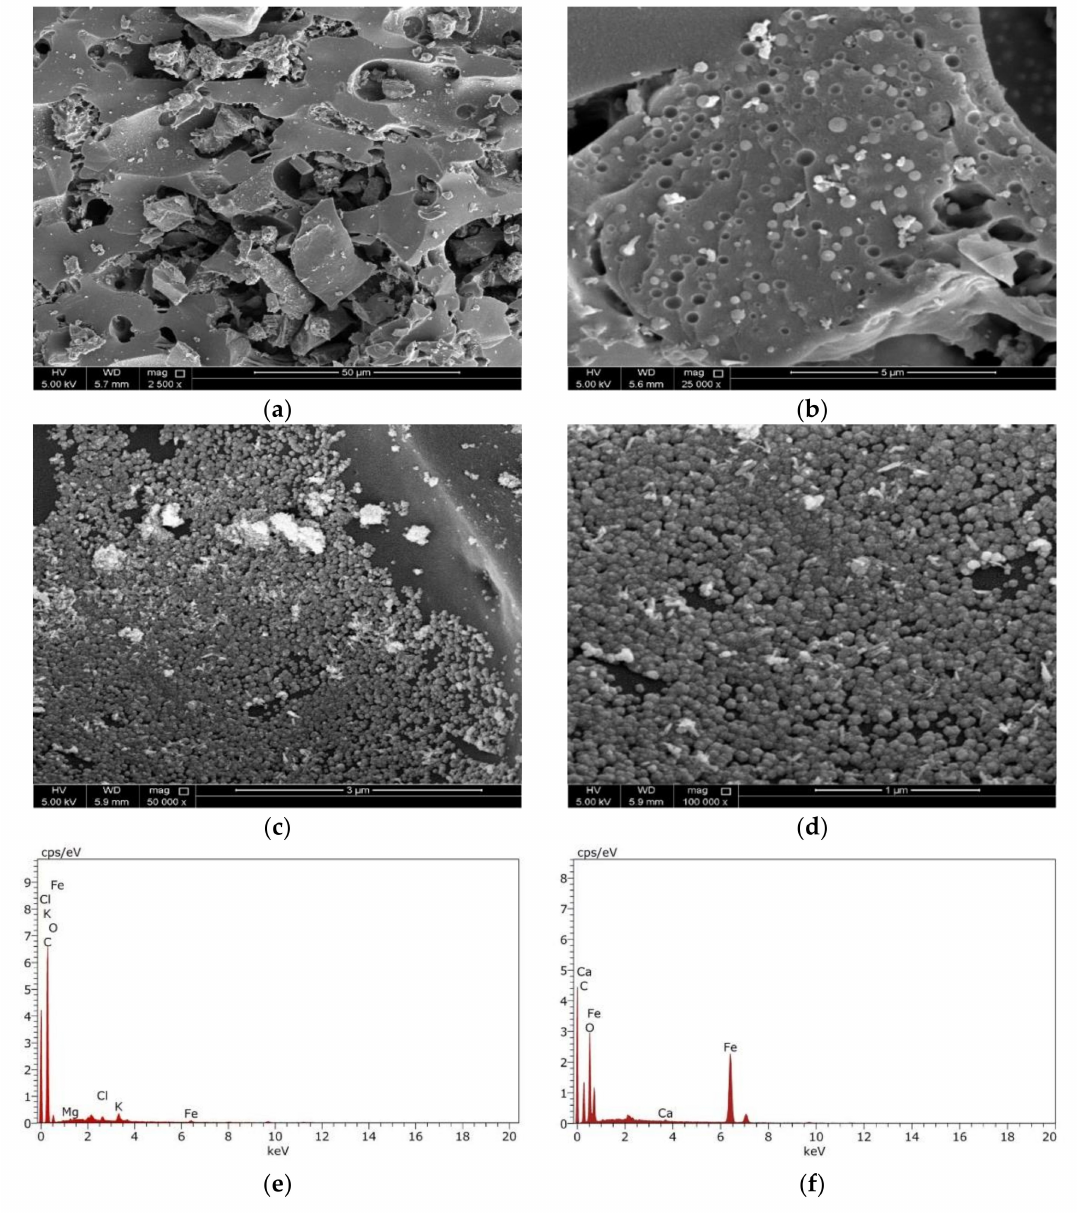
Figure 4. SEM micrographs of BCDP with magnification ( a ) 2500 × , ( b ) 25,000 × , and MBC-DP with magnification ( c ) 50,000 × , ( d ) 100,000 × , and EDX analysis for BCDP ( e ) and MBC-DP ( f